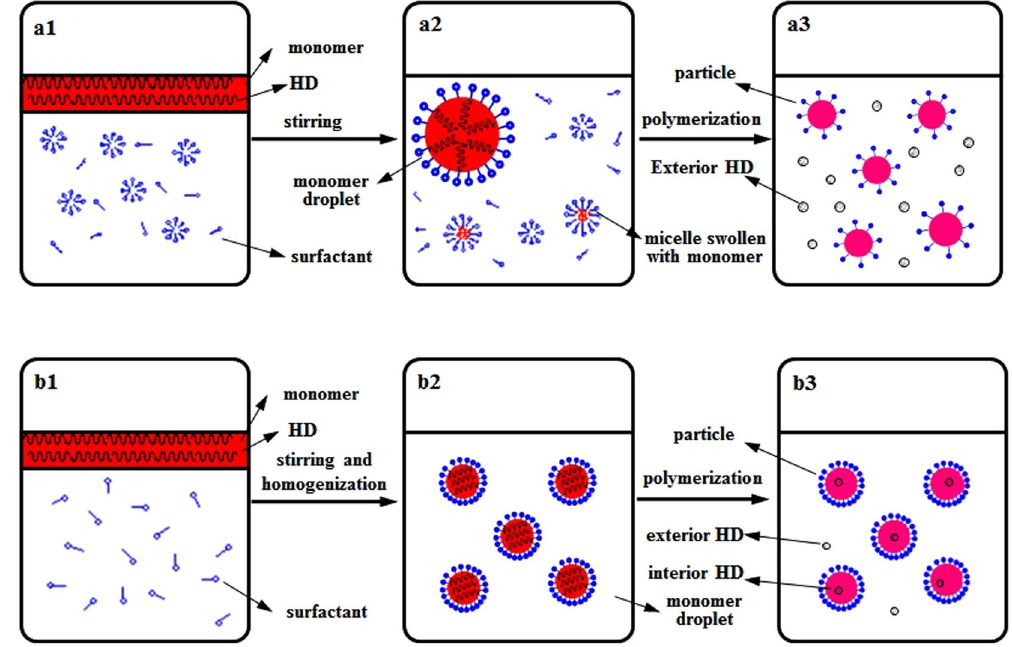
Figure 1. Schemes for the distribution of HD in monomer droplets and particles during the polymerization process for CEP + HD ( a ) and MP ( b ). CEP + HD represents the emulsion containing HD synthesized by conventional emulsion polymerization CEP, MP signifies miniemulsion